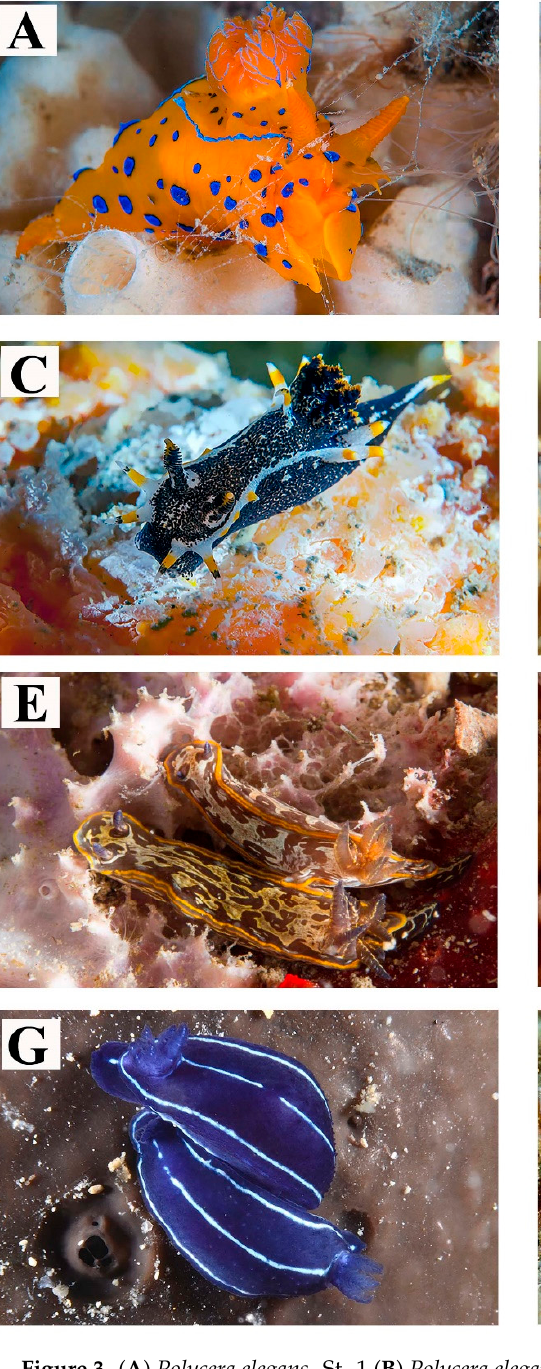
Figure 3. ( A ) Polycera elegans. St. 1 ( B ) Polycera elegans. St. 1 ( C ) Polycera hedgpethi. St. 1 ( D ) Polycera hedgpethi . Two individuals after mating. The reproductive openings are clearly visible in the specimen on the upper portion. St. 1 ( E ) Felimare fontandraui . St. 11 ( F ) Felimare fontandraui , mating individuals with spawn. St. 11 ( G ) Felimare orsinii , mating individuals. St. 14 ( H ) Felimida binza. St. 25.